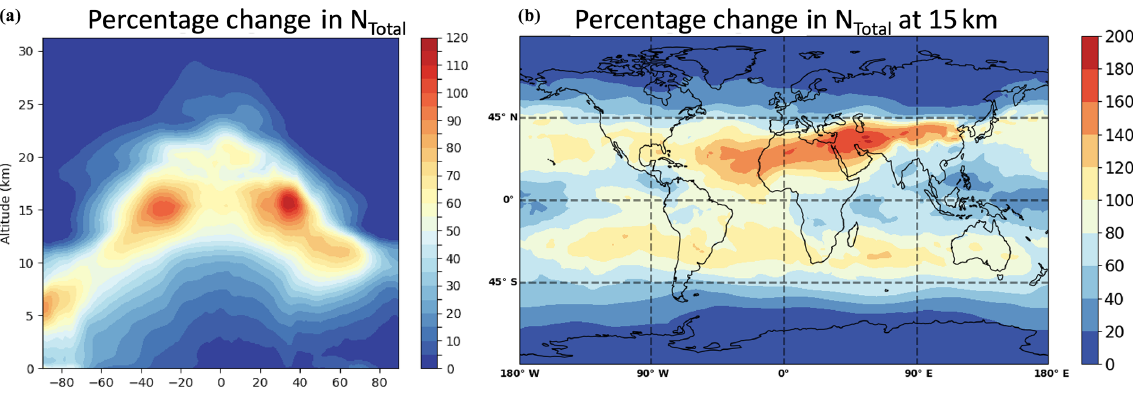
Figure 5. Increased global aerosol number concentrations due to collision enhancement. Results from a global modelling study of the present-day atmosphere. Panel (a) shows the relative change in the total aerosol number concentration (particles larger 3nm) averaged over all longitudes in a vertical profile if collision enhancement is considered in sulfuric acid growth. Panel (b) shows the relative increase at an altitude of 15km on a global scale where the effects are most significant. Higher relative changes would also be expected at lower altitudes if the model is adjusted for ternary sulfuric acid–water–ammonia